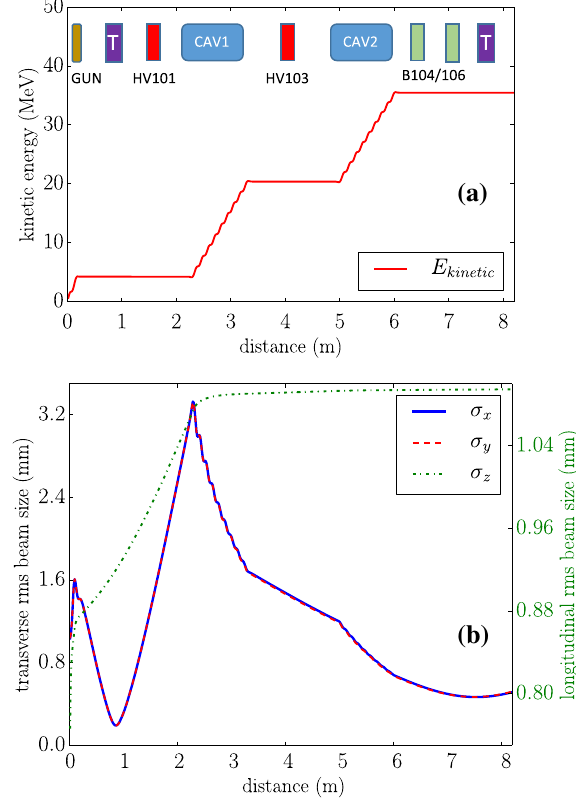
FIG. 4. Experimental setup under consideration and associated energy gain (a) and transverse and longitudinal bunch sizes (b) simulated with A STRA . In the diagram displayed in (a), the labels “ CAV, ” “ T, ” “ HV, ” and “ B ” respectively correspond to the SRF cavities, the integrated-current monitors (ICM), the mag- netic steerers, and beam-position